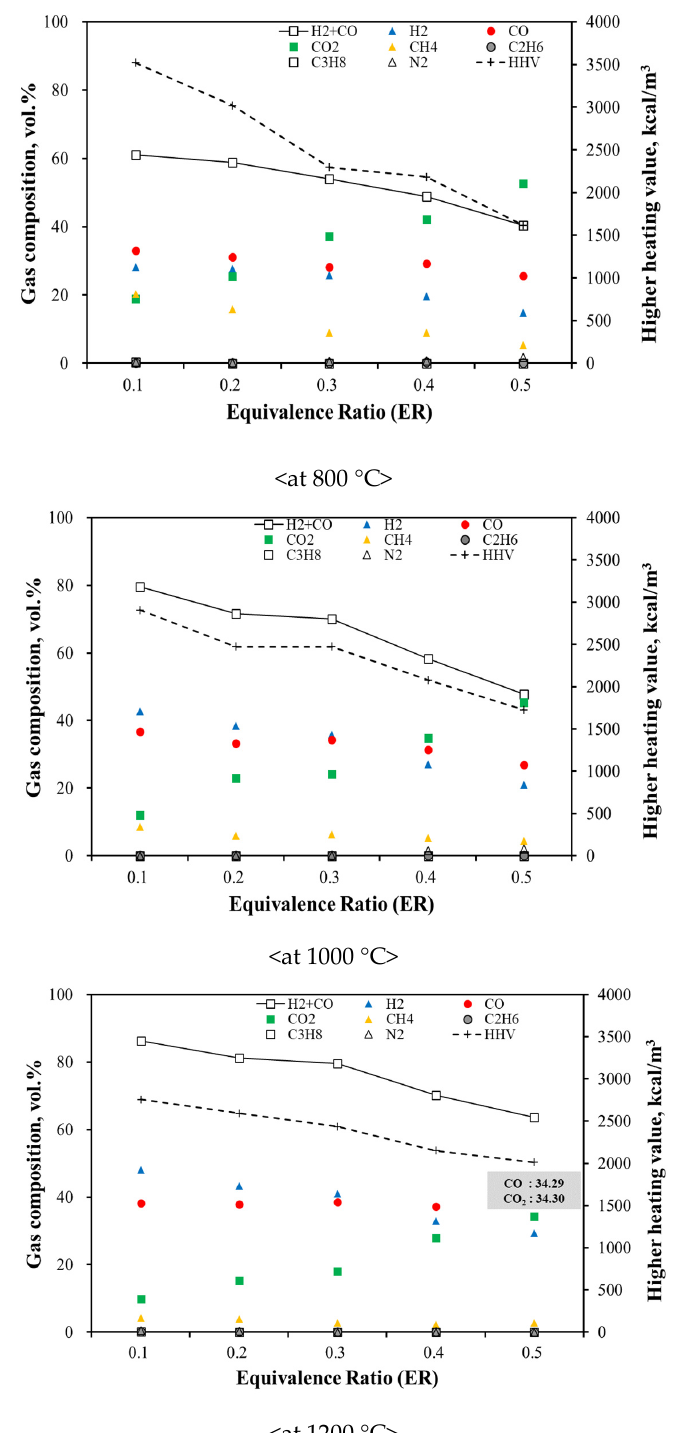
Figure 5. Gas Composition with Different Temperatures and ER from ASR Gasification.